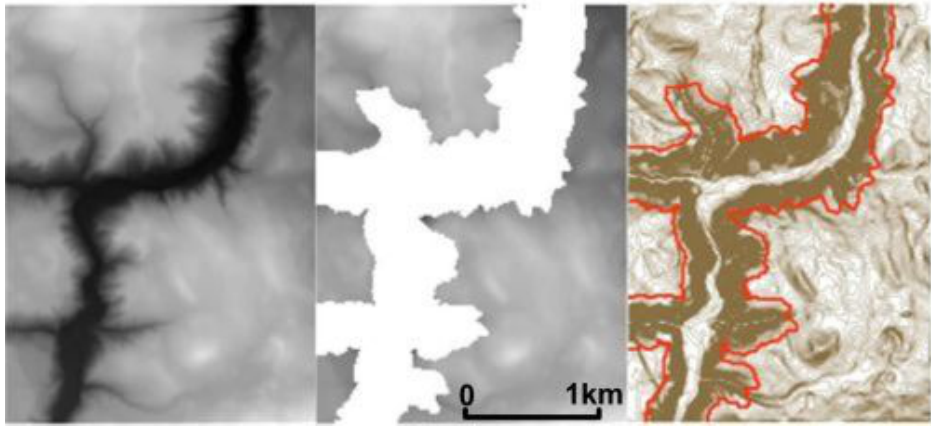
extracted canyon (middle – white area) The border line of the extracted canyon (red) overlaid onto the contour map (right) with the equidistance of 25 m derived from the first DTM.